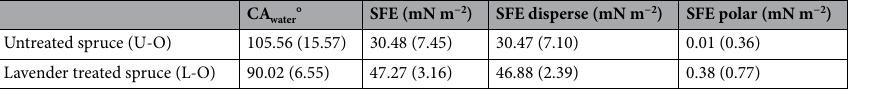
Table 3. CA° and SFE of Norway spruce wood without and with lavender treatment. Mean values are from 8 replicates; Numbers in parentheses are SD.